Question: Looking at the figure, what chart type is it?
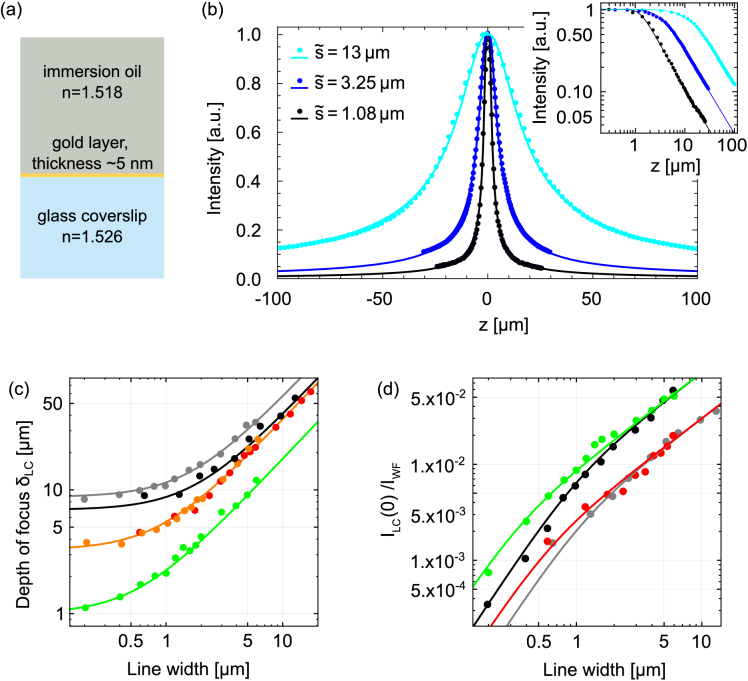
Answer: line